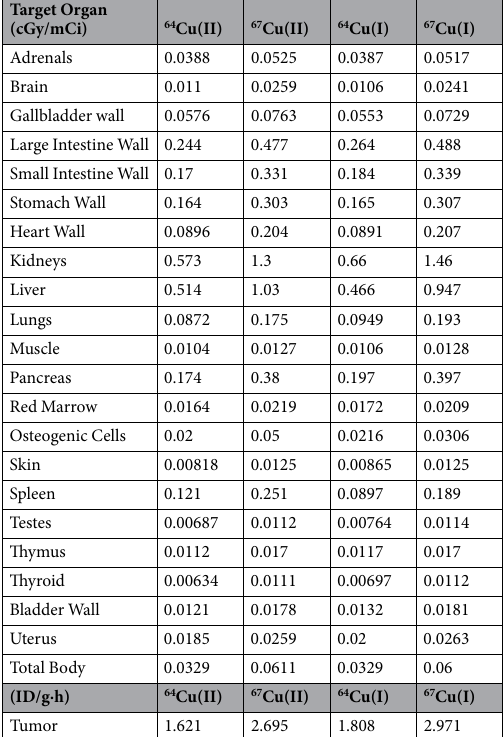
Table 4. Estimated radiation absorbed doses of 67/64 Cu(II/I) in major organs of an adult male patient based on the biodistribution data obtained from B16F10 tumor-bearing